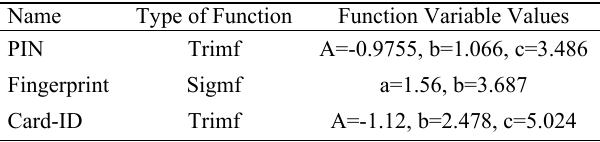
Table 5: Fuzzification functions and variable values using